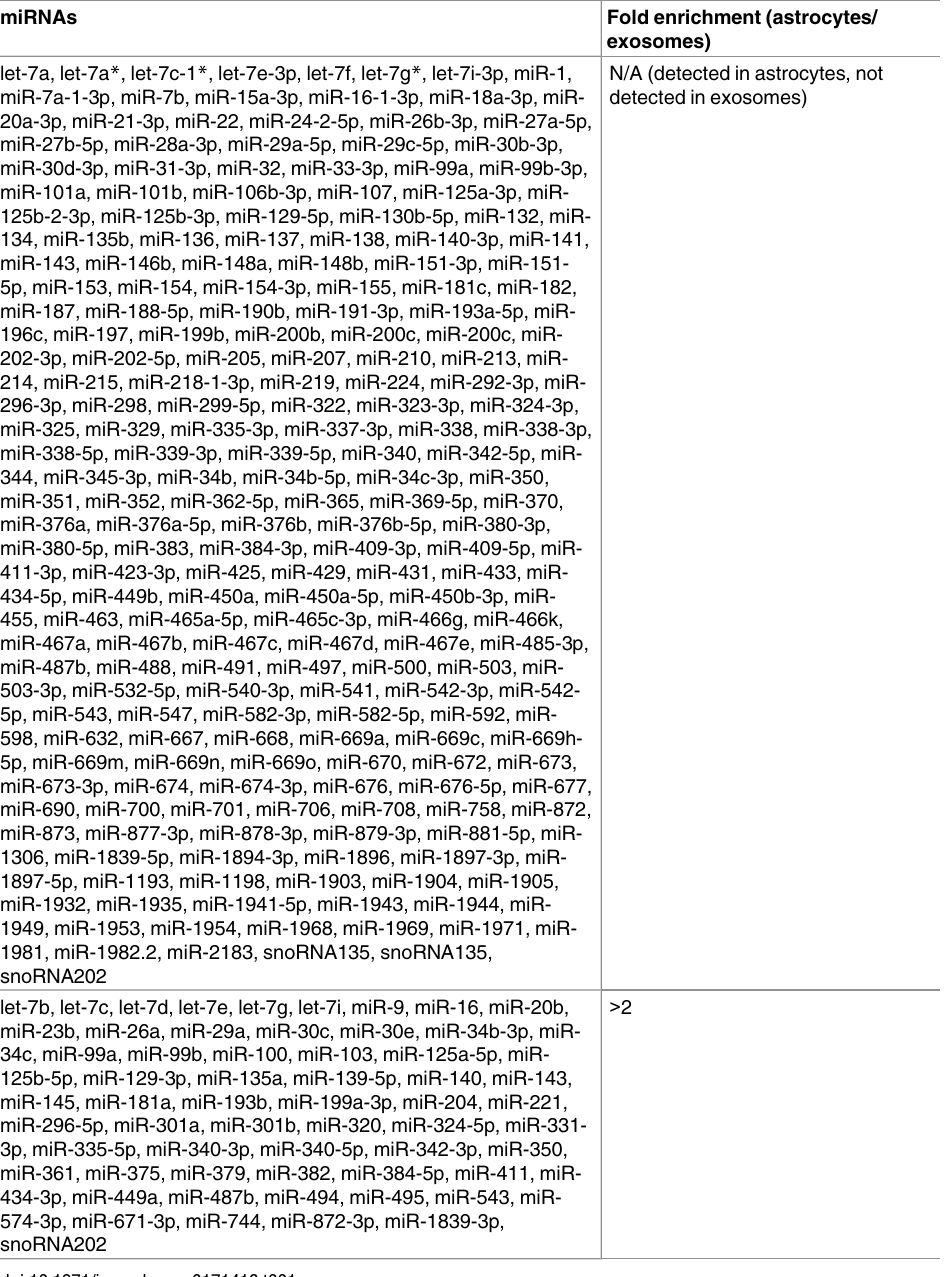
Table 1. miRNAs enriched in astrocytes compared to exosomes. miRNAs Fold enrichment (astrocytes/